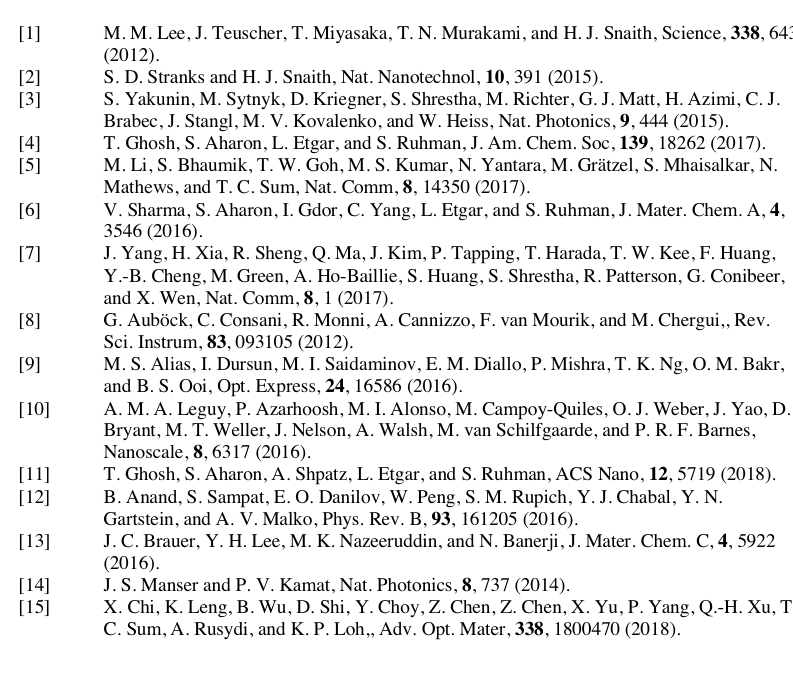
Fig. 2. Schematic band diagram with the expected assigned photobleached transitions in MAPbBr 3 following 3.1 eV excitation.